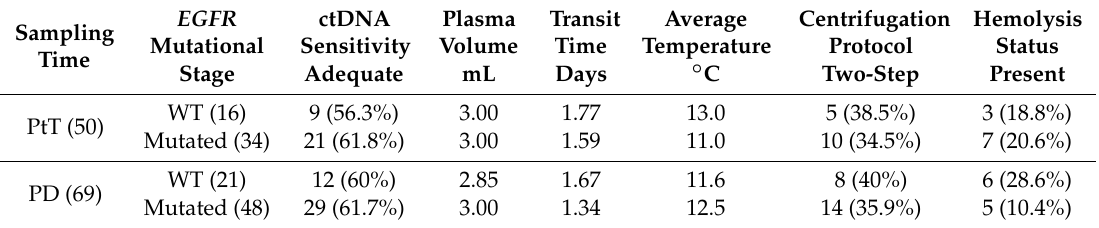
Table 2. Detection of mutations in plasma samples taken prior to therapy and at radiologic progression in relation to pre-analytical